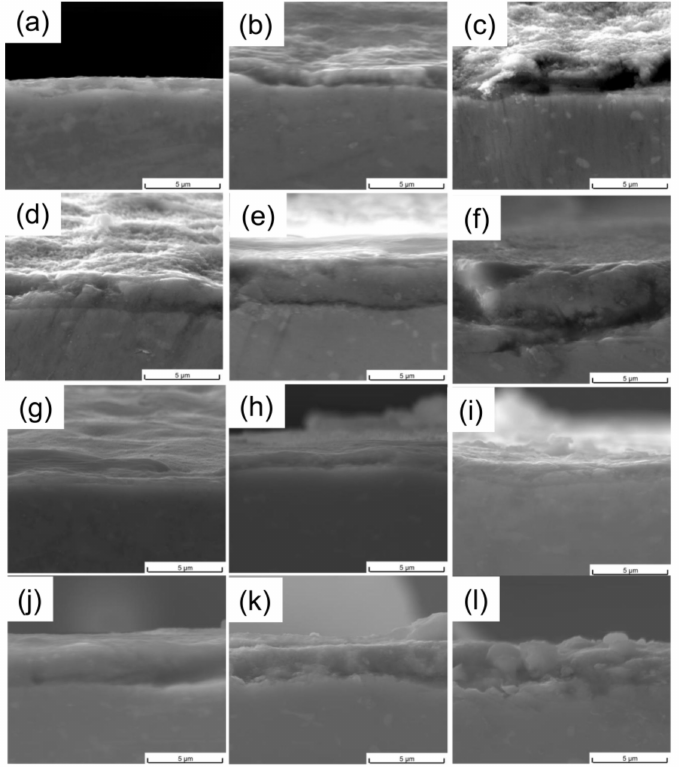
Figure 4. Microscopic SEM images of the removal of the oxide film section with different heating times: ( a – f ) silicon carbide (SiC) paper, ( a ) 0.5 h, ( b ) 1 h, ( c ) 2 h, ( d ) 4 h, ( e ) 6 h and ( f ) 8 h; ( g – l ) laser